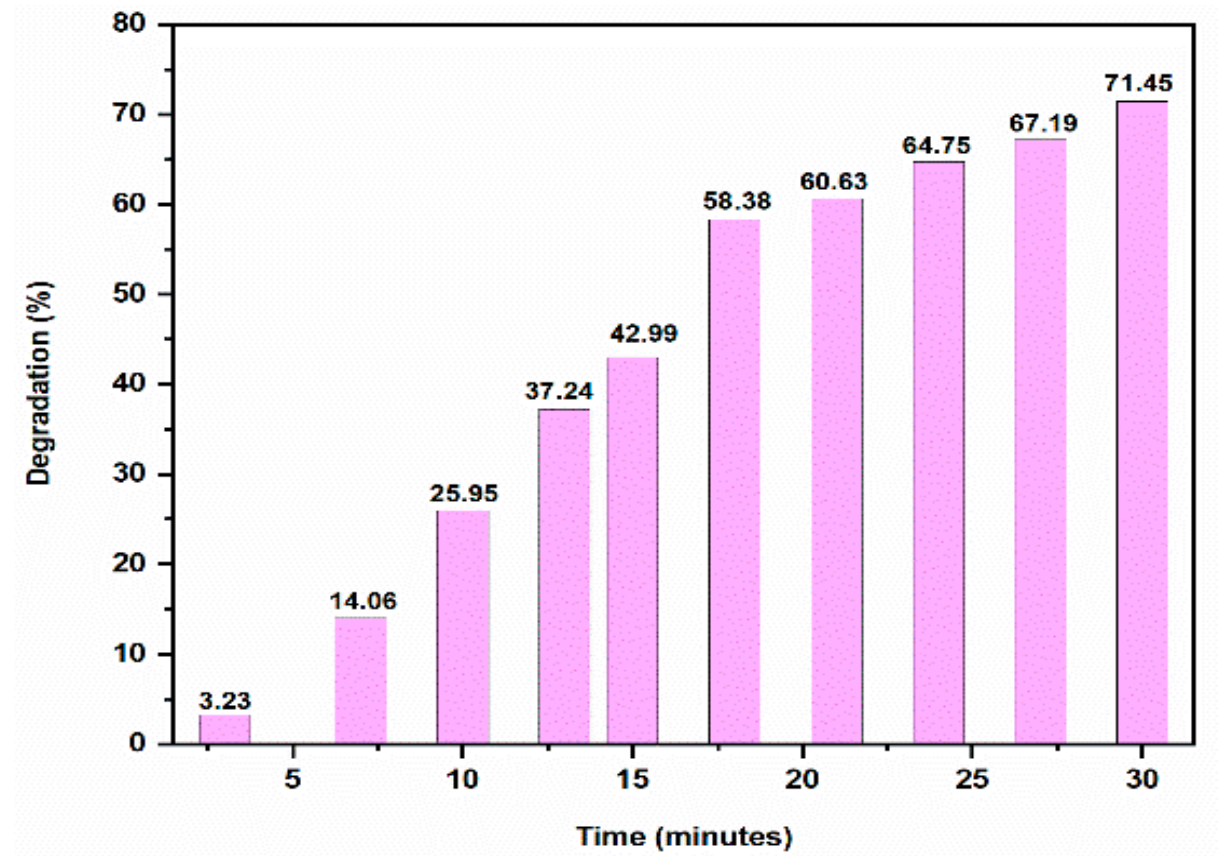
Figure 12. Bar graph of MO degradation at different time intervals.